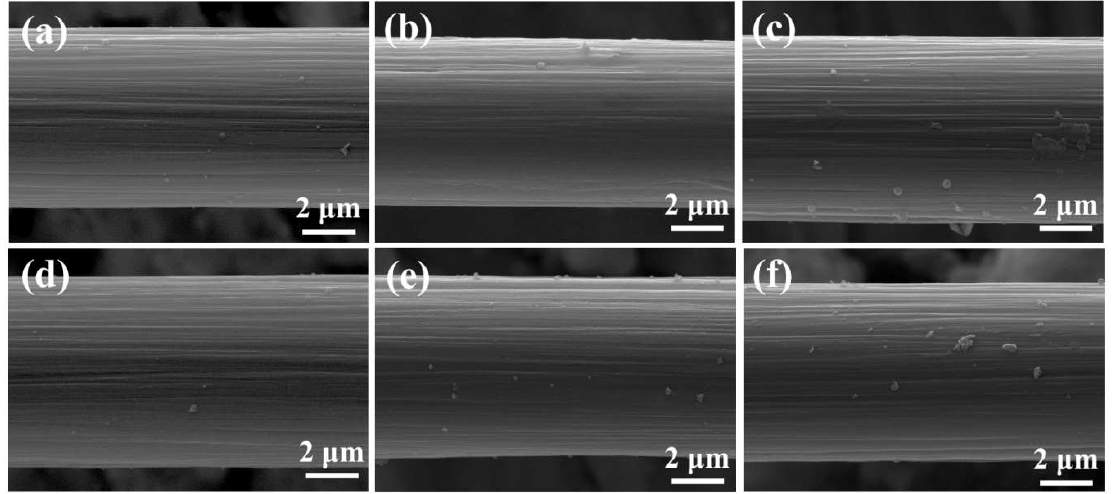
Figure 4. SEM images of carbon fibers (CFs) at different plasma treatment times: ( a ) untreated CF, ( b ) CF–AA15 (Ar 15 s, air 15 s), ( c ) CF–air, ( d ) CF–Ar, ( e ) CF–AA1 (Ar 1 min, air 1 min), and ( f ) CF–AA5